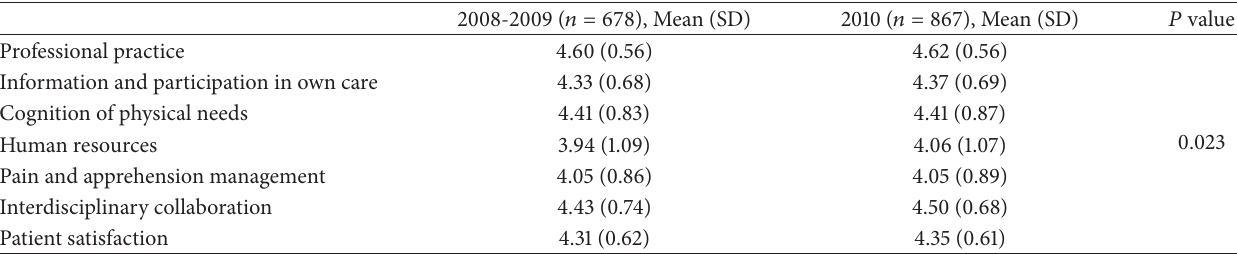
Table 4: Patient satisfaction scores in 2008-2009 and 2010-2011. Scores range from 1 to 5, with 1 being the lowest and 5 being the highest. Differences between the two survey periods were considered significant if 𝑃 <